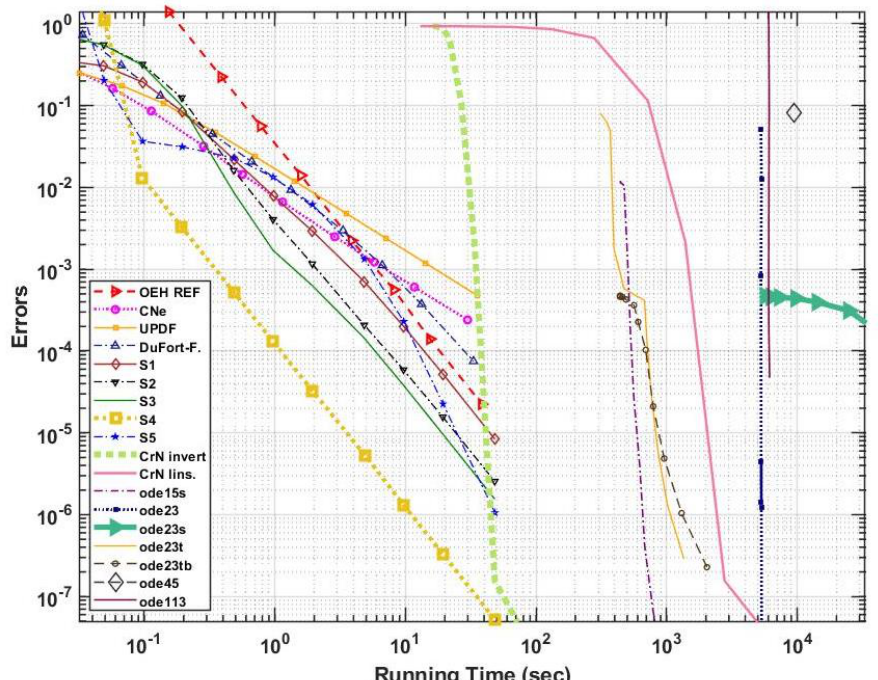
Figure 7. L ∞ errors as a function of the running time for the second (very stiff) system, in the case of the original OEH method (OEH REF), one-stage CNe and UPFD methods, the Dufort–Frankel method, the new algorithms S1–S5, and the Crank–Nicolson with two implementations and different MATLAB routines. Table 2. Comparison of different algorithms for the very stiff system of 10,000 cells. Numerical